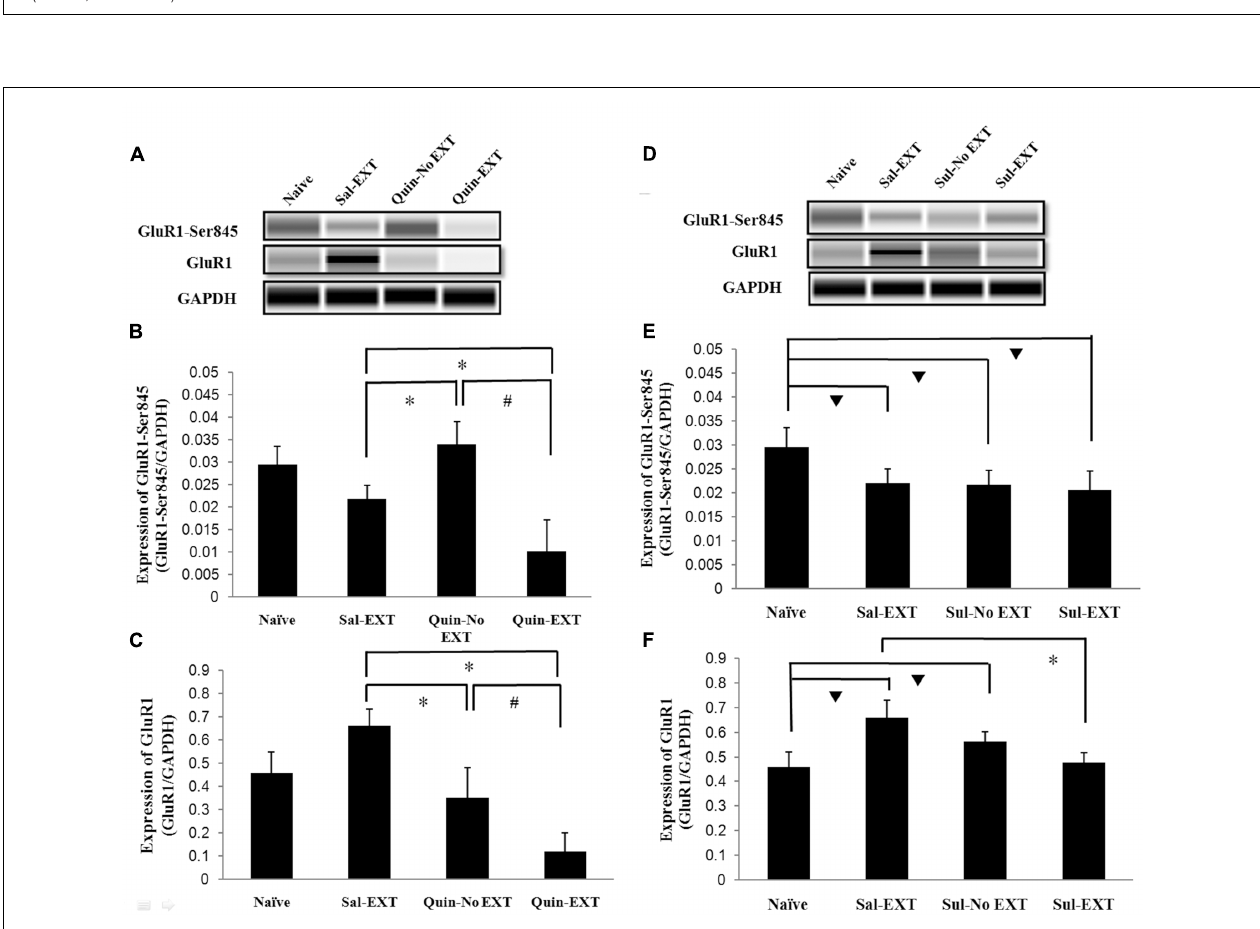
FIGURE 5 | The effects of sulpiride microinfusion to the BLA before extinction training on LTM. (A) Rats were presented with three pairings of tone and footshock in the conditioning chamber. (B) Administration of sulpiride before extinction training impaired within-session extinction ( ∗ P < 0.05). (C) The total freezing levels of LTM after fear extinction training following sulpiride administration. The LTM level of the Sul-EXT group ( n = 15) was also significantly higher than that of the Sal-EXT group II ( n = 14, ∗ P < 0.05).